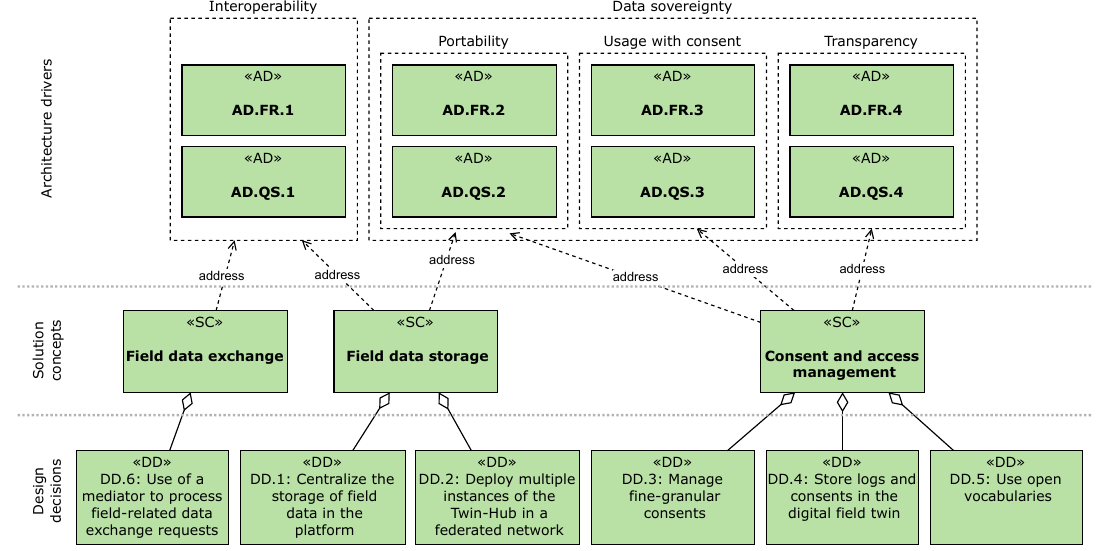
Figure 3. Architecture drivers (ADs), solution concepts (SCs), and design decisions